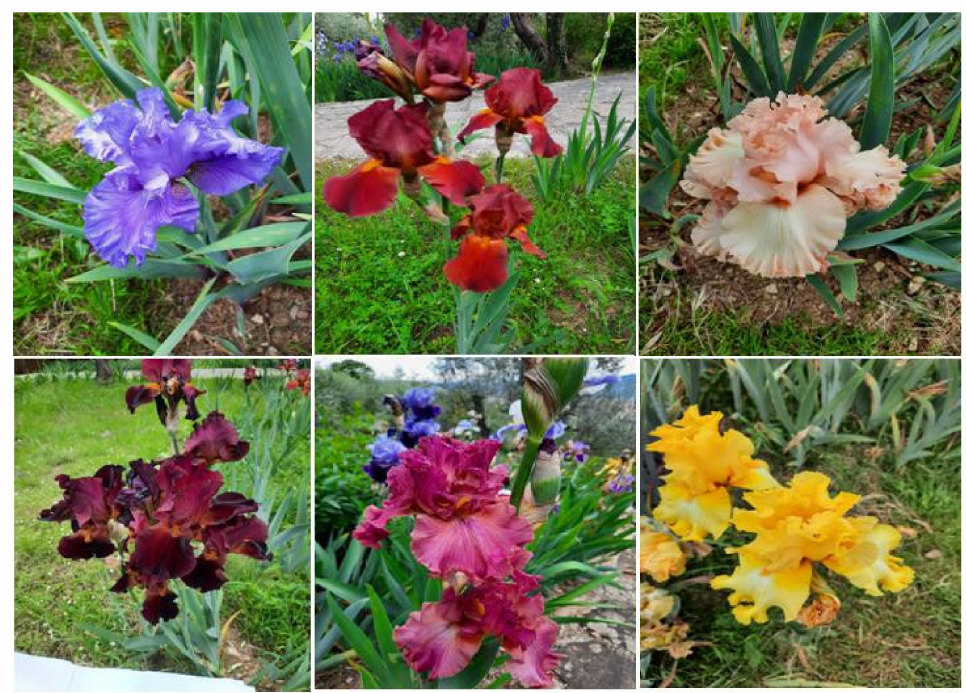
Figure 1. A collection of pictures of various Iris spp. taken at “ Iris Garden”, Florence, Italy.